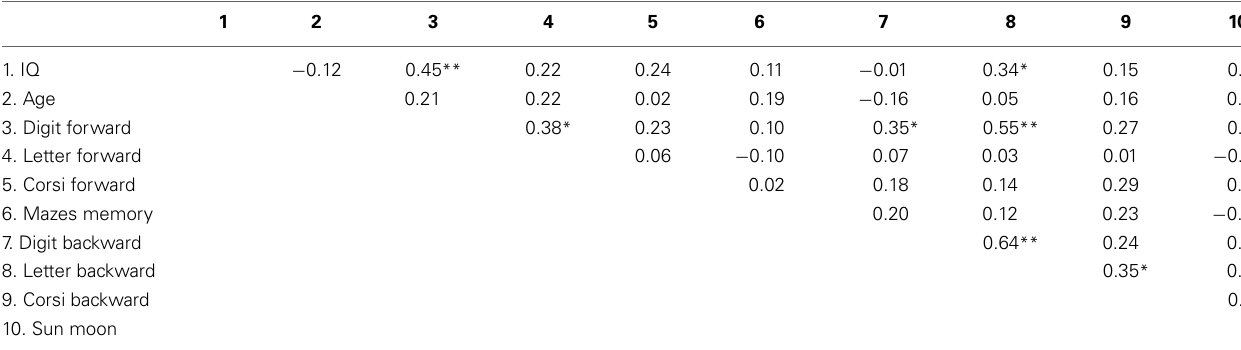
Table 3 | Correlations between IQ, age, and the working-memory tasks.